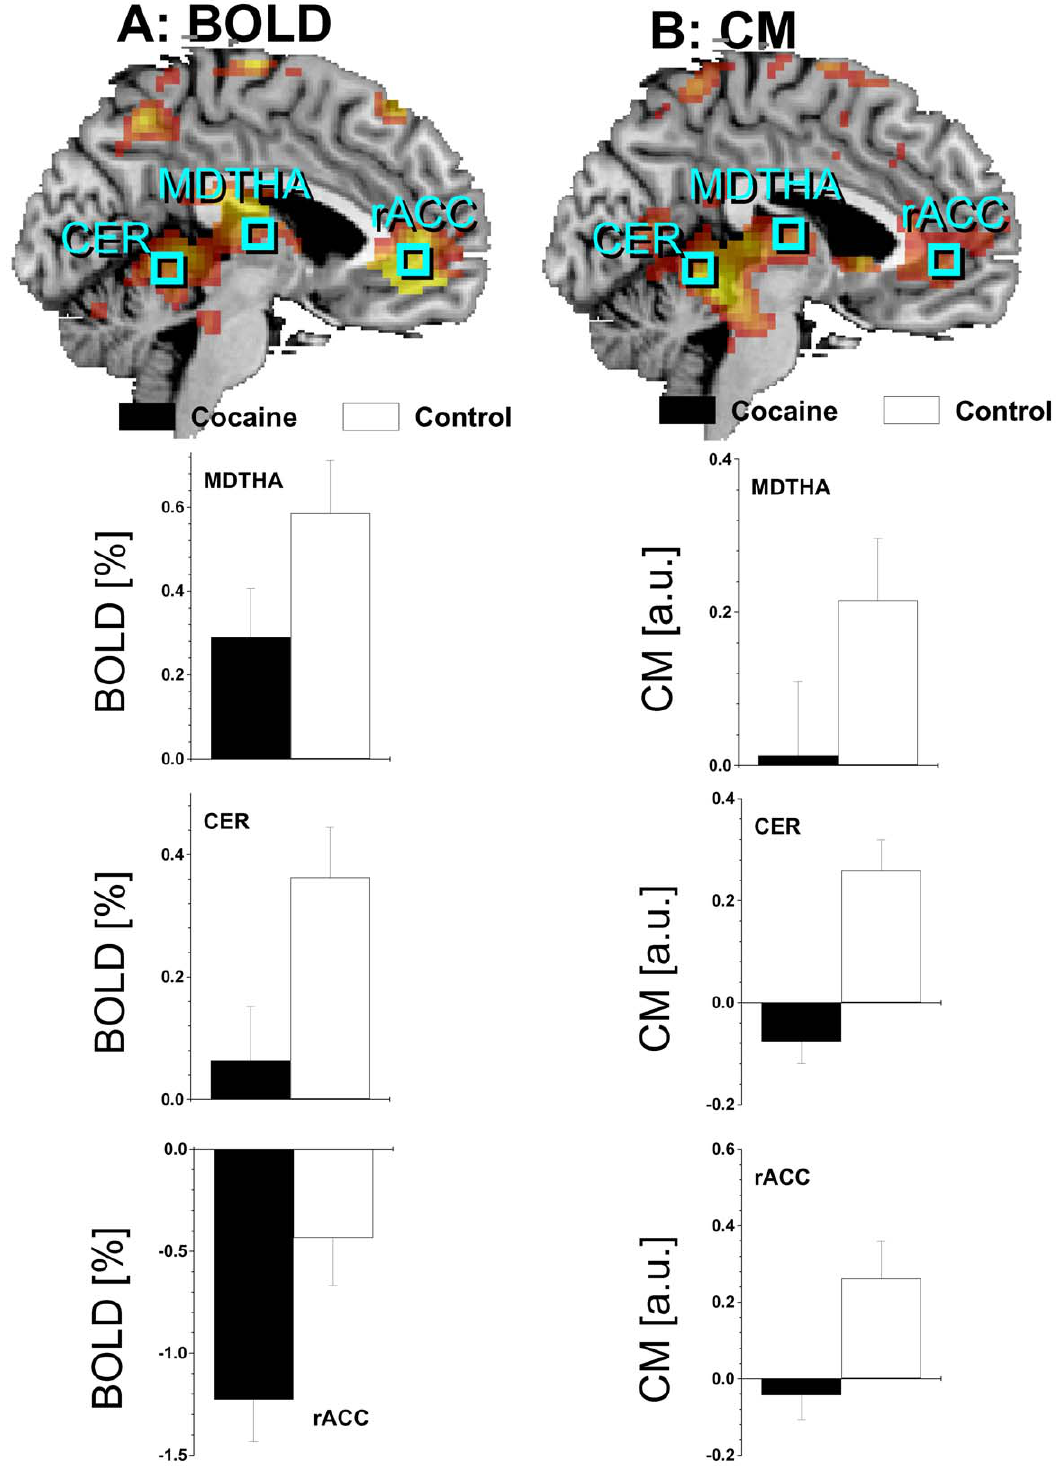
Figure 5. Brain activation and functional connectivity of midbrain. A: Statistical map of BOLD-fMRI signals during the DW task across word conditions (conjunctive analysis ‘‘Drug’’ + ‘‘Neutral’’ vs. resting baseline) for controls . cocaine, superimposed on a sagittal view of the human brain. The light-blue squares and labels mark the positions of relevant ROI. The left side bar plots display the average BOLD responses in these regions for the cocaine and control groups (P , 0.05). 5B: Statistical map of correlations with midbrain (CM) across word conditions (conjunctive analysis ‘‘Drug’’ + ‘‘Neutral’’ vs. resting baseline) for controls . cocaine, superimposed on a sagittal view of the human brain. The right side bar plots display the average CM signals in these regions for the cocaine and control groups (P , 0.05). SPM Model: two-way repeated measures ANOVA. Sample: cocaine (N=20) and control (N=20) subjects. MDTHA: medial dorsal nucleus of the thalamus; CER: cerebellum (culmen); rACC: rostral anterior cingulate cortex (BA 32). ROI volume=27 voxels (0.73 cc). Error bars are standard errors. CER: cerebellum; MDTHA: medial dorsal nucleus of the thalamus; rACC: rostral Anterior cingulate cortex.